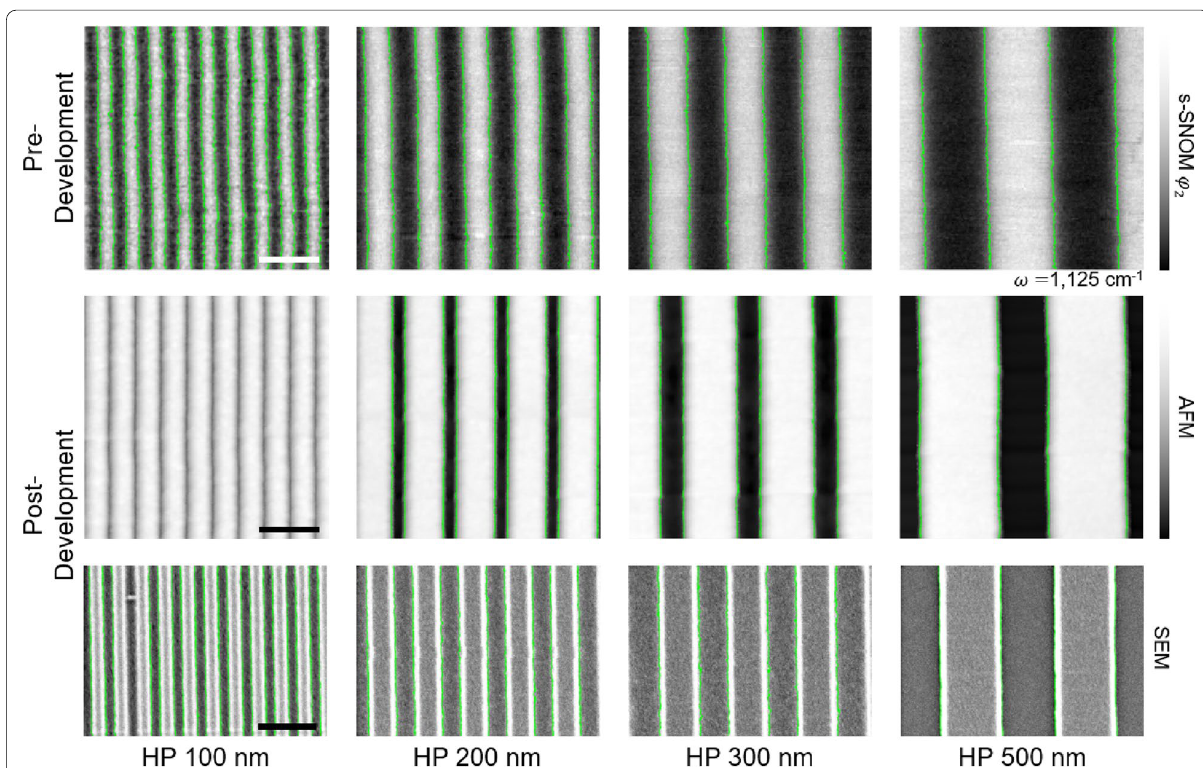
Fig. 5 LER analysis images of HP 100, 200, 300, and 500 nm. (Top) s‑SNOM results of latent images that were taken with a 1125 cm − 1 infrared laser. (Middle) AFM topographic and (bottom) scanning electron microscopy (SEM) results of the developed pattern. Due to the 3‑dimensional (3D) shape of the probe tip, the AFM could not visualize the HP 100 nm pattern. The LER values of the HP 200 and 300 nm patterns for SEM are overestimated due to the weak image contrast. The scale bar is 500 nm for all cases